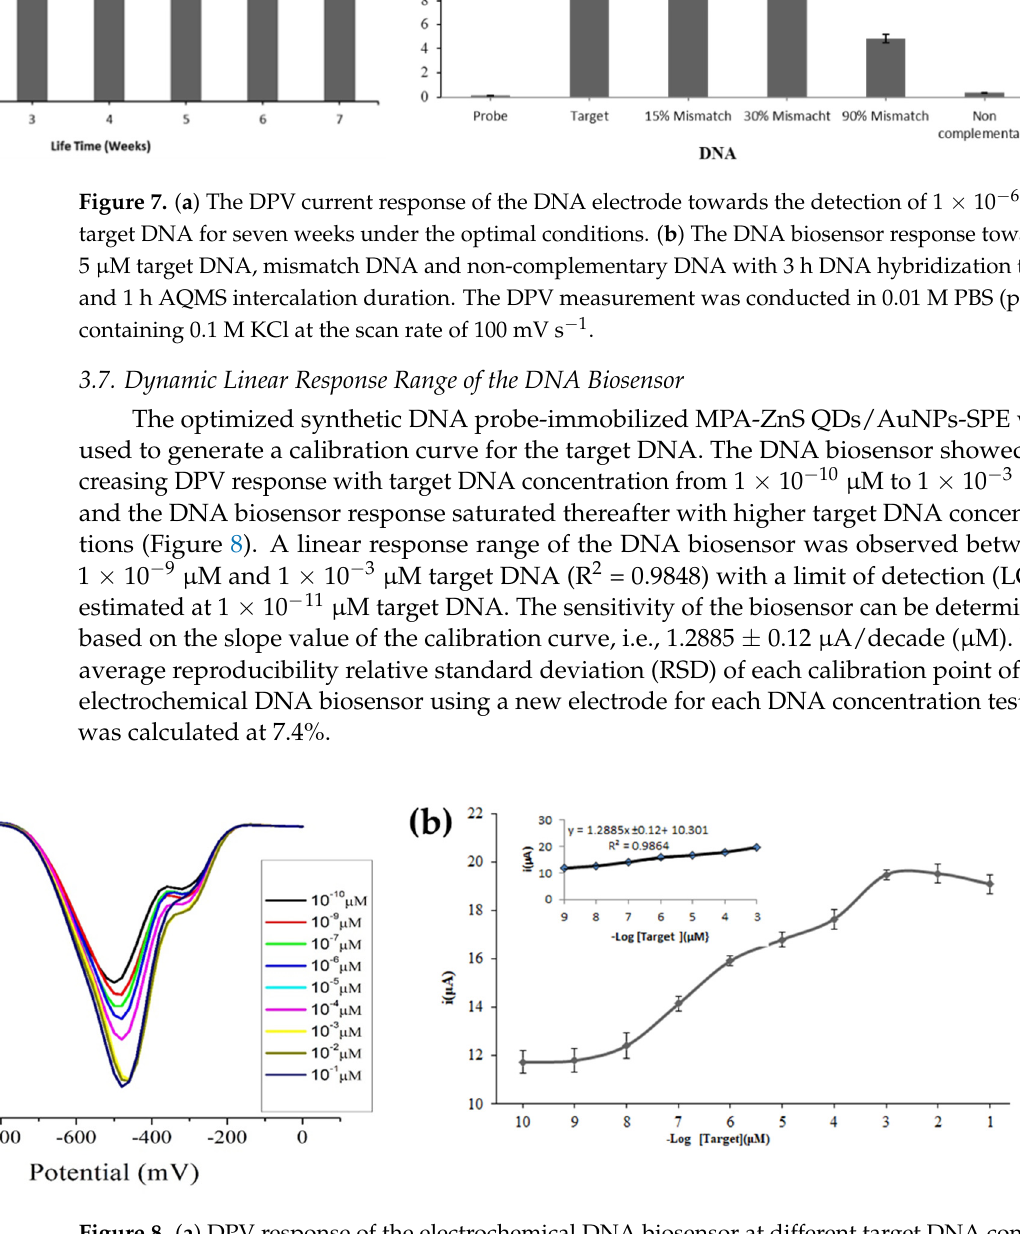
Figure 8. ( a ) DPV response of the electrochemical DNA biosensor at different target DNA concen- trations. ( b ) The response curve of the electrochemical DNA biosensor established with different concentrations of target DNA from 1 × 10 − 10 µ M to 1 × 10 − 1 µ M. The inset shows the linear calibration curve of the DNA biosensor from 1 × 10 − 9 µ M to 1 × 10 − 3 µ M target DNA.